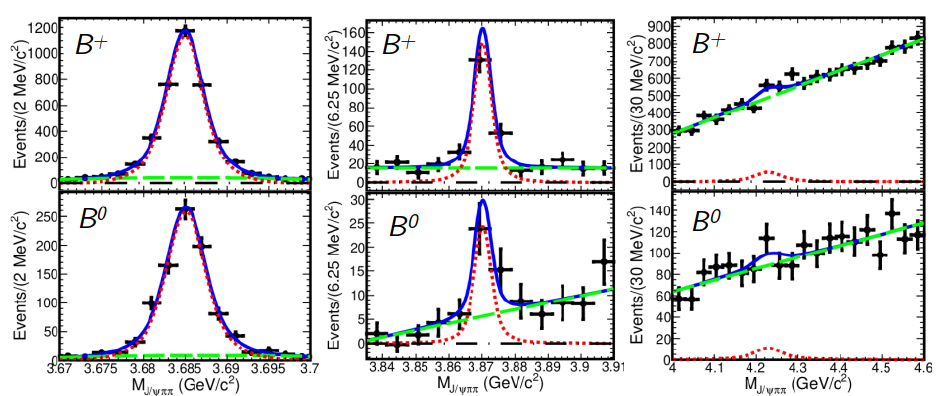
Figure 1. Invariant m ( J / ψπ + π − ) mass distributions of B + → K + J / ψπ + π − decays (top) and B 0 → K 0 J / ψπ + π − decays (bottom) at Belle, using the complete recorded data set of 711 fb − 1 . Left: s zoom to mass region of ψ (cid:48) , center: zoom to mass region of X (3872), and right: zoom to mass region of Y (4260).